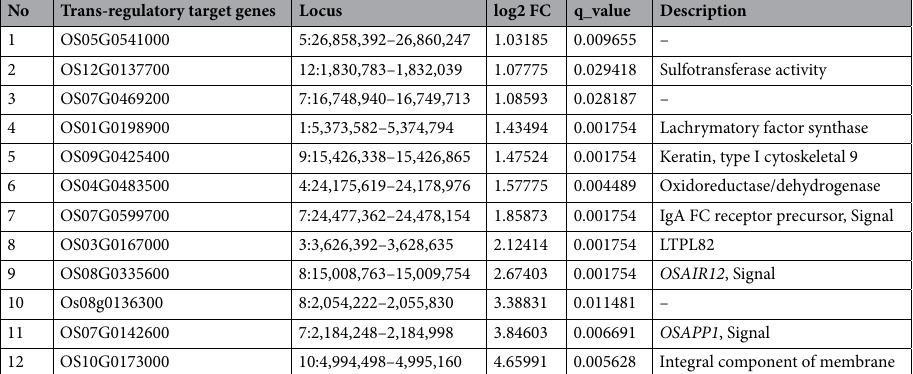
Table 3. The specific trans -regulatory target genes of FL478 with common TFBS in cis -regulatory target gene of lncRNA.2-FL.